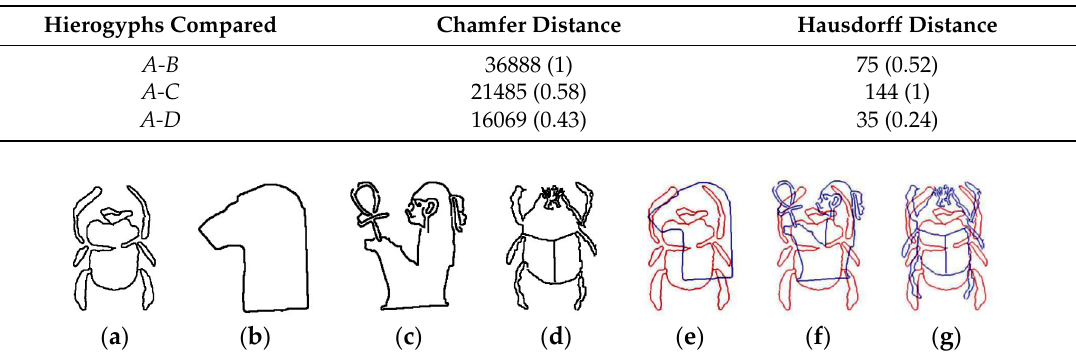
Figure 8. ( a ) Hieroglyph from a database to be used as a reference; ( b – d ) Hieroglyphs extracted from several cartouches; ( e – g ) Overlapped images.